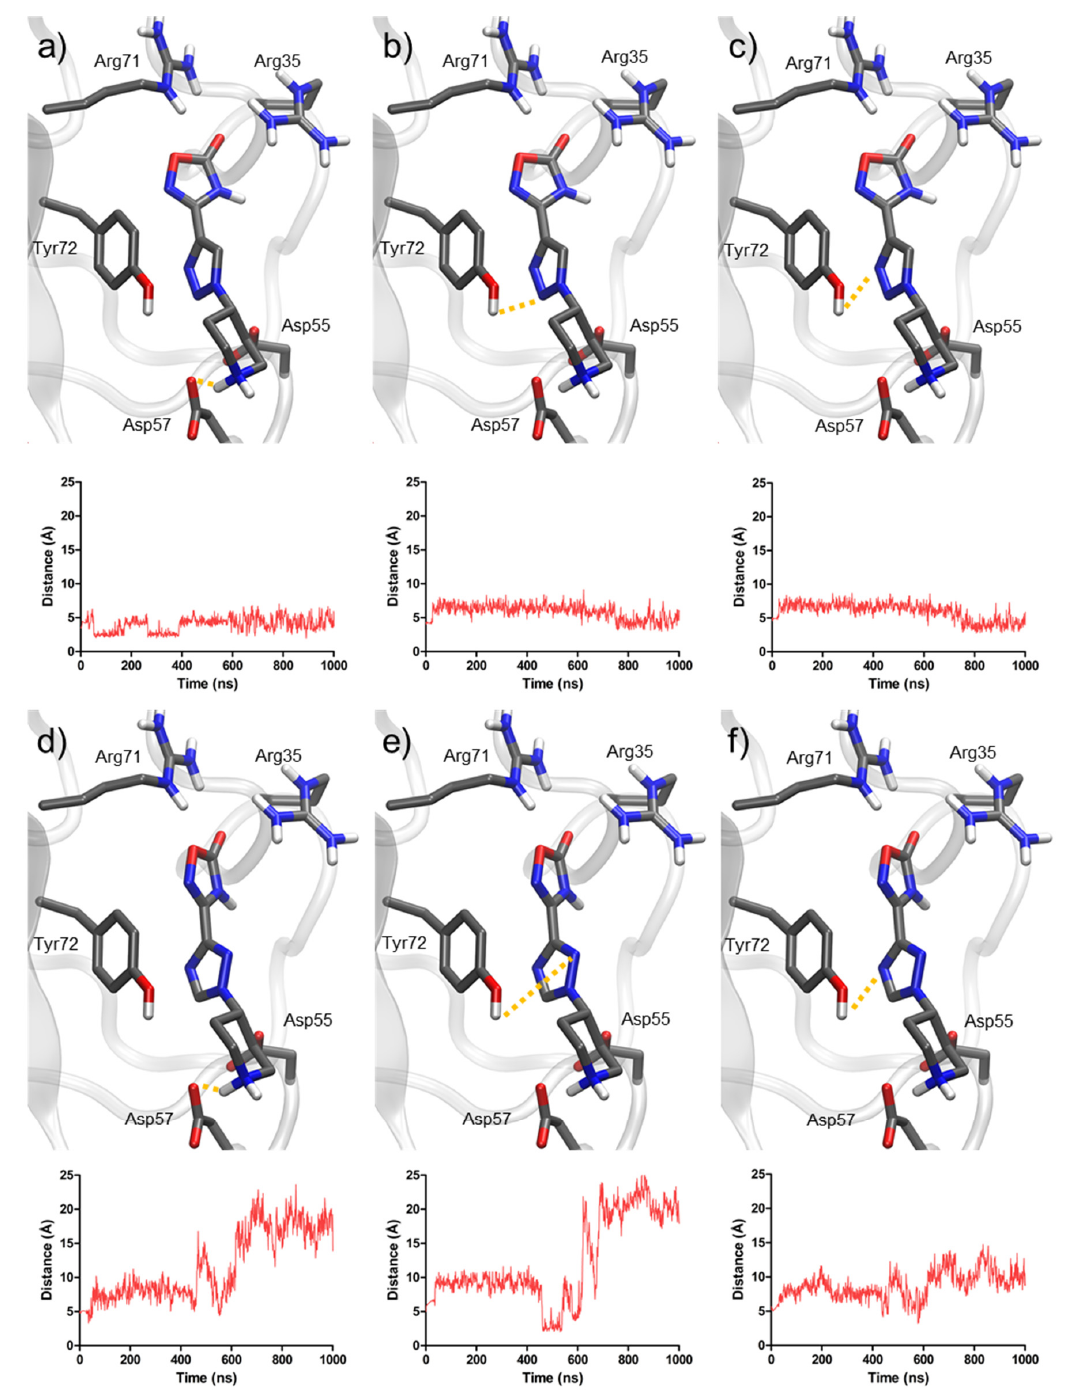
Figure 7. Docking of most representative poses for 1,2,4-triazole derivatives (compounds 9 and 10 ). Docking studies were performed with Kringle 1 lysine binding site (pdb code 1cea) using AutoDock 4.2. The molecular dynamics simulations (Figure 8) showed a clearly different behavior for compounds 1 and 9 . Molecule 1 (1,2,3-triazole) remained inside the binding site throughout the entire simulation time (1000 ns), while molecule 9 (1,2,4-triazole) did not, abandoning it at 500–600 ns.